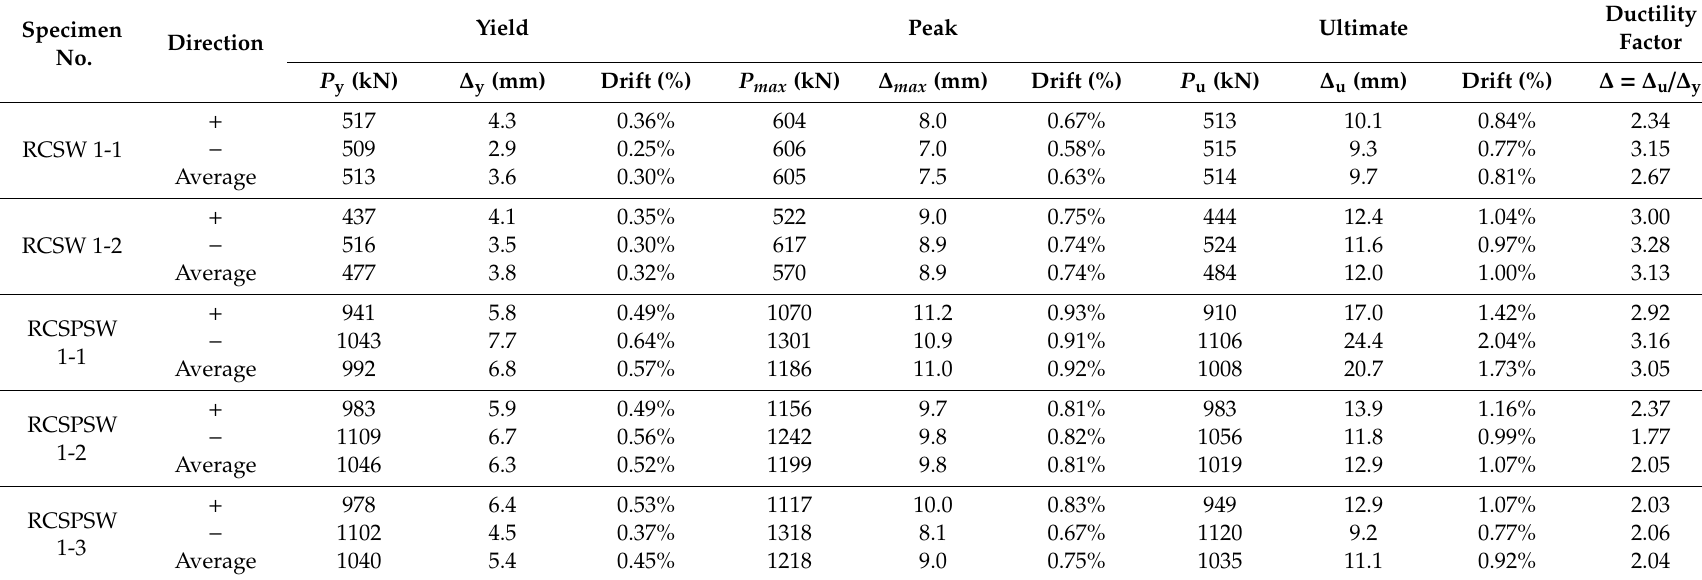
Table 3. Lateral Load and Displacement Capacity of Shear